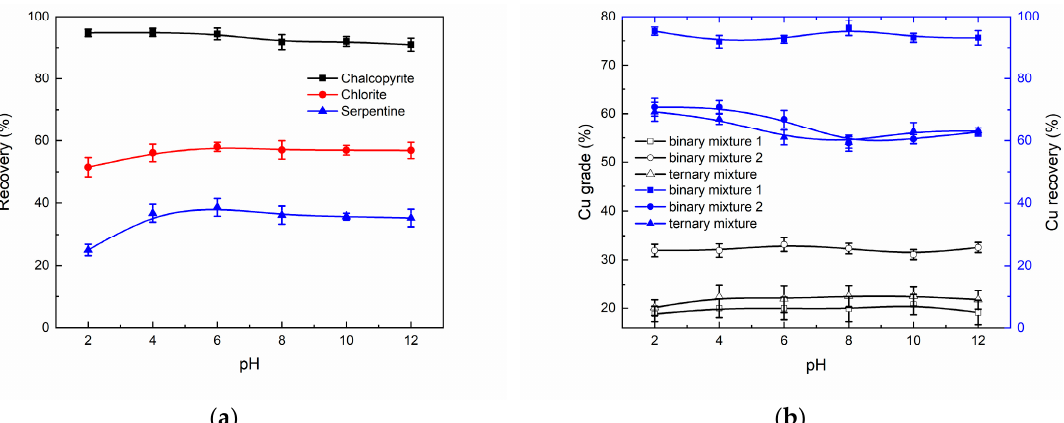
Figure 4. Effect of pH on the flotation behavior of single minerals ( a ) and mixed minerals ( b ). [sodium amyl xanthate (SAX)] = 20 mg/L; [methyl isobutyl carbinol (MIBC)] = 20 mg/L; binary mixture 1: the mixture of chalcopyrite and chlorite; binary mixture 2: the mixture of chalcopyrite and serpentine.